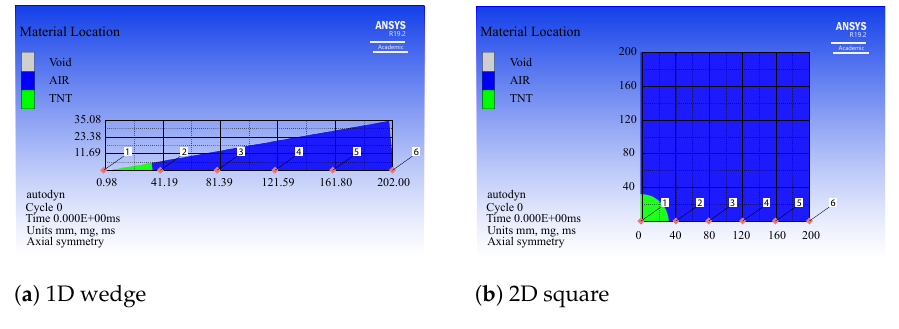
Figure 3. 1D and 2D numerical